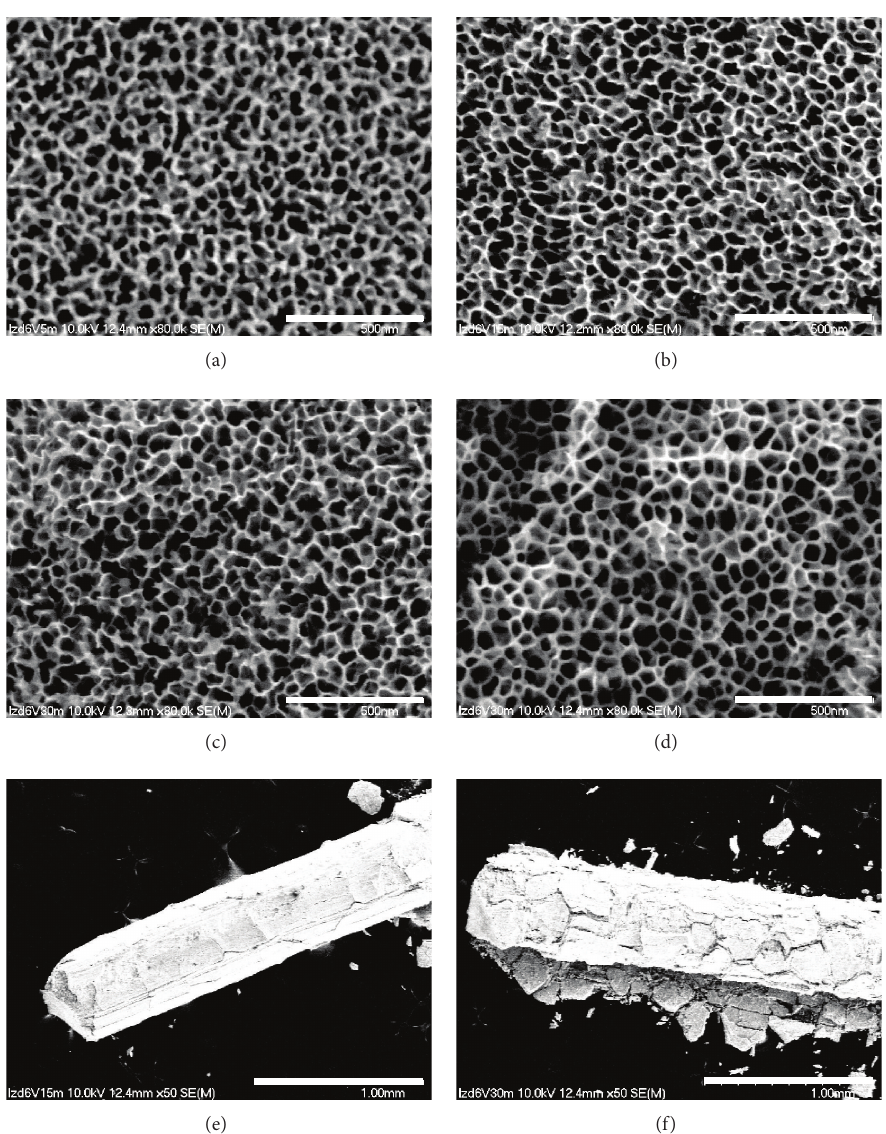
Figure9:FE-SEMimagesofnanoporoustinoxidelayersformedduringone-stepanodizingofSnwirein0.3 Moxalicacidat6 V.Theduration of anodization was 5min (a), 15min (b, e), and 30min ((c): “outer” layer, (d): “inner” layer, and